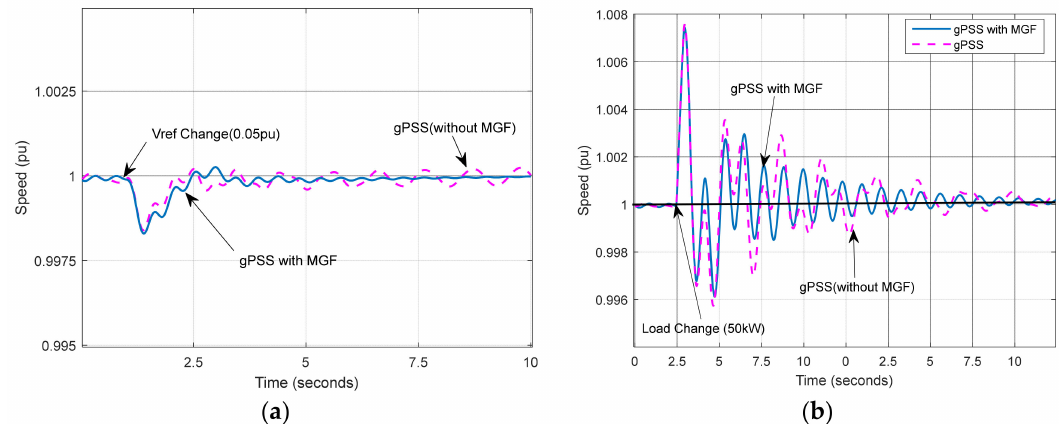
Figure 11. Generator speed variations with small disturbances (system load: 3 MW; initial loading of SG: 0.5 pu (1 MW); reference voltage of AVR: 1 pu): ( a ) In the case of the reference voltage change (0.05 pu) and ( b ) In the case of the load change (50